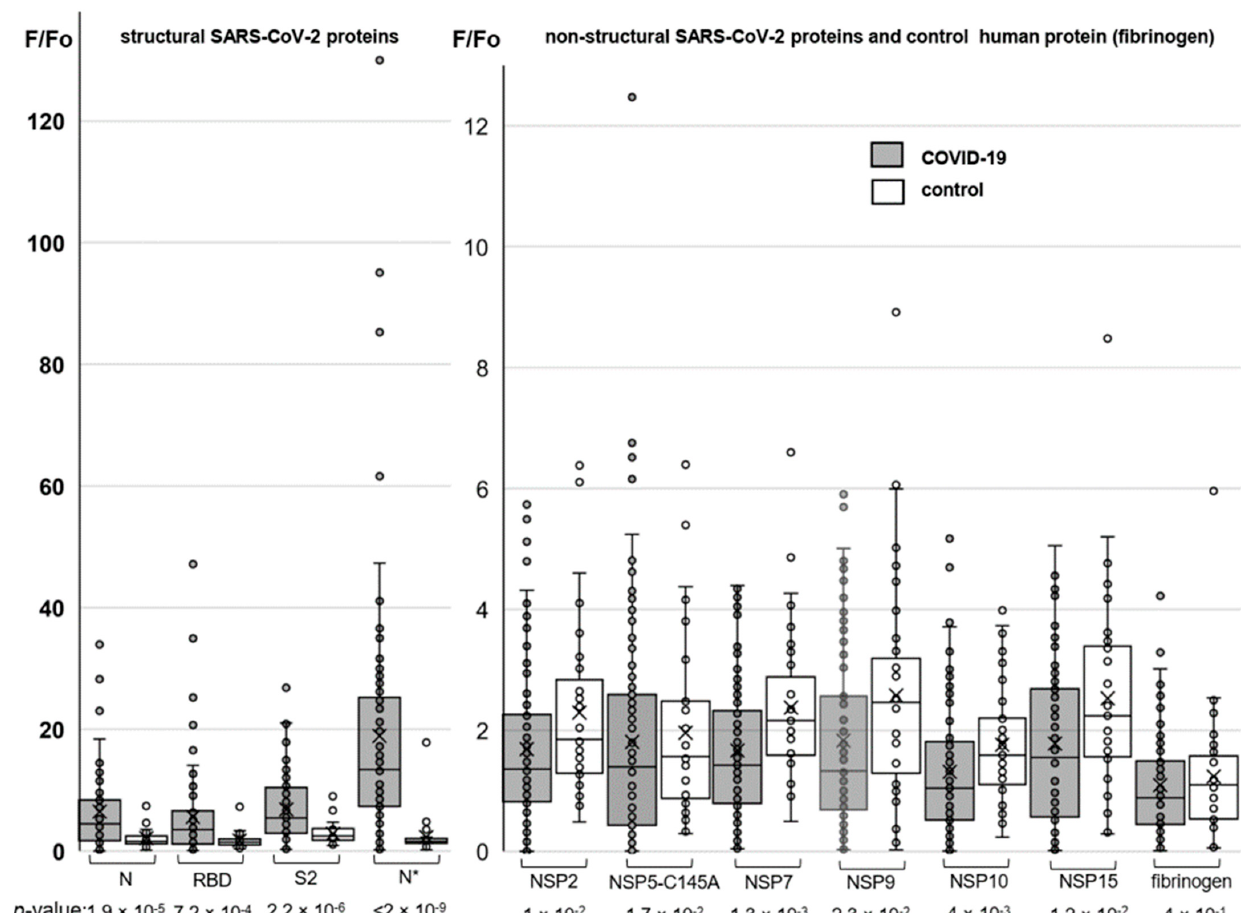
Figure 3. Profiling responses to the structural (left) and non-structural (right) SARS-CoV-2 proteins using protein microarrays. The box plots summarize the distributions of the relative levels of antibodies to particular proteins detected in COVID-19-positive donors (numbers of samples: 95 for SARS-CoV-2 proteins and 80 for fibrinogen) and the control group (numbers of samples: 37 for SARS-CoV-2 proteins and 34 for fibrinogen).